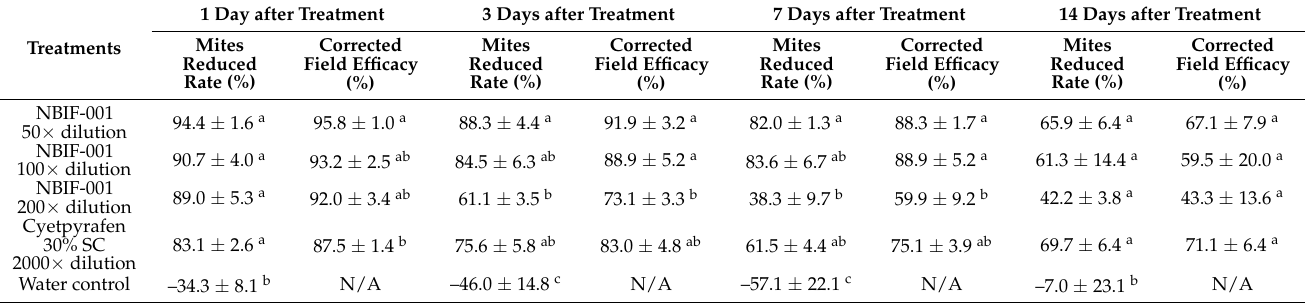
Table 3. The corrected field efficacy of Bacillus vallismortis NBIF-001 against Panonychus citri .